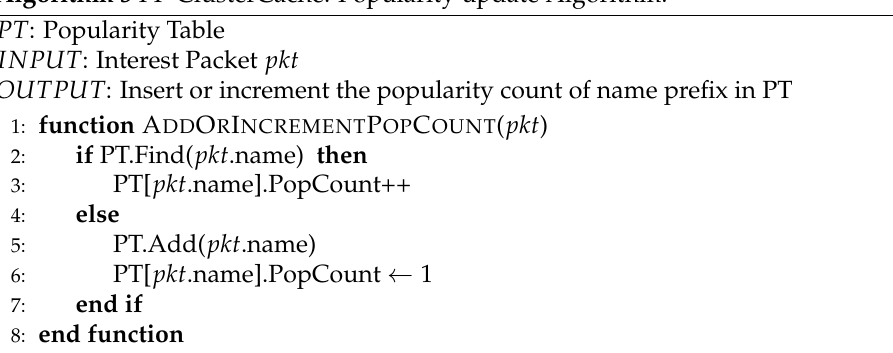
Algorithm 3 PF-ClusterCache: Popularity update